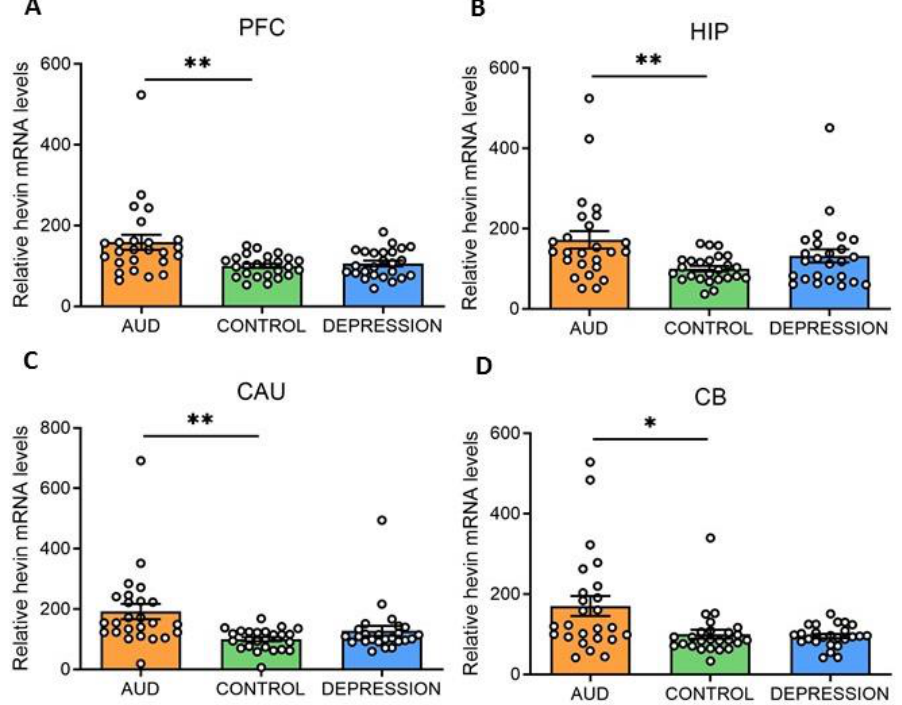
Figure 1. Hevin mRNA expression in postmortem human brains of alcohol use disorder (AUD) subjects. Relative hevin mRNA levels were quantified by RT-qPCR in postmortem brain samples from subjects with AUD, depression and controls in the prefrontal cortex (PFC) ( A ), hippocampus (HIP) ( B ), caudate nucleus (CAU) ( C ) and cerebellum (CB) ( D ). n = 25 per group. One-way ANOVA followed by Dunnett’s post-hoc test, * p < 0.05, ** p < 0.01. Samples were run in triplicate. Bars show mean ± SEM, dots represent the average value of each individual.